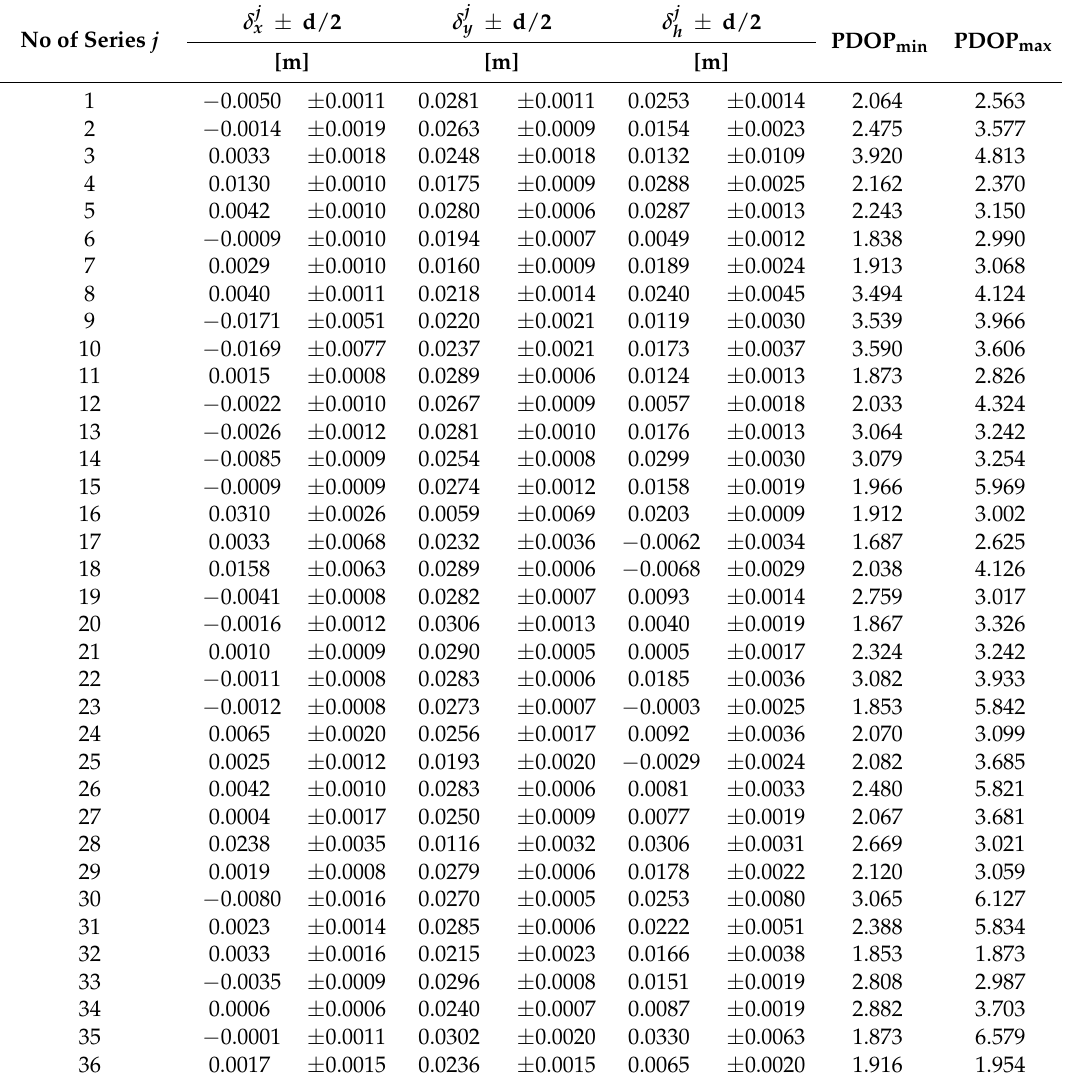
Table 9. Systematic errors of measurements together with the length of confidence intervals (d/2) at the confidence level of 0.95 and the minimum (PDOPmin) and maximum (PDOPmax) values of PDOP parameters for each